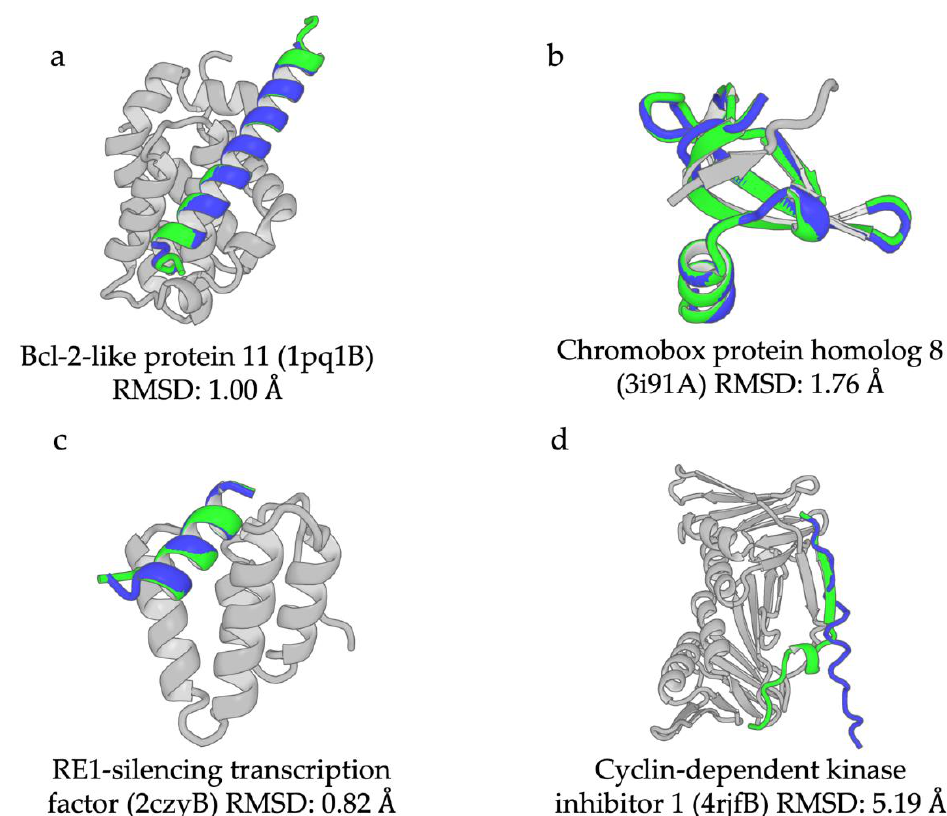
Figure 3. Examples of ProSs in the excellent and poor classes. ProS, the binding partner of ProS, and the AF2 model are represented in green, gray, and blue, respectively. (a) – (c) Examples of ex-cellent and (d) poor classes. (a) The ProS in Bcl-2-like protein 11 (residues 139 – 171) comprises a long α helix (1pq1B). (b) The ProS in chromobox protein homolog 8 (residues 9 – 60) comprises an entire structural domain (3i91A). (c) The ProS in RE1-silencing transcription factor (residues 43 – 57) comprises a short helix with terminal loops (2czyB). (d) The ProS in cyclin-dependent kinase inhibitor 1 (residues 141 – 160) comprises an extended shape (4rjfB).